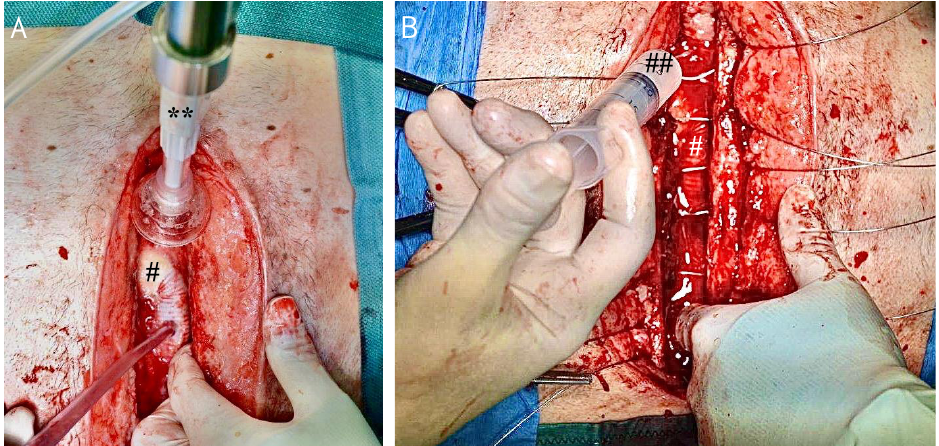
Figure 2. Intraoperative setup during wound closure. ( A ) For debridement purposes, pulsatile jet lavage (**) was applied in order to minimize local bacterial concentrations at the outflow graft (#). ( B ) Viscous bacteriophage-enriched galenic (##) was injected at the infection site before sternal closure with standard stainless-steel cerclages.